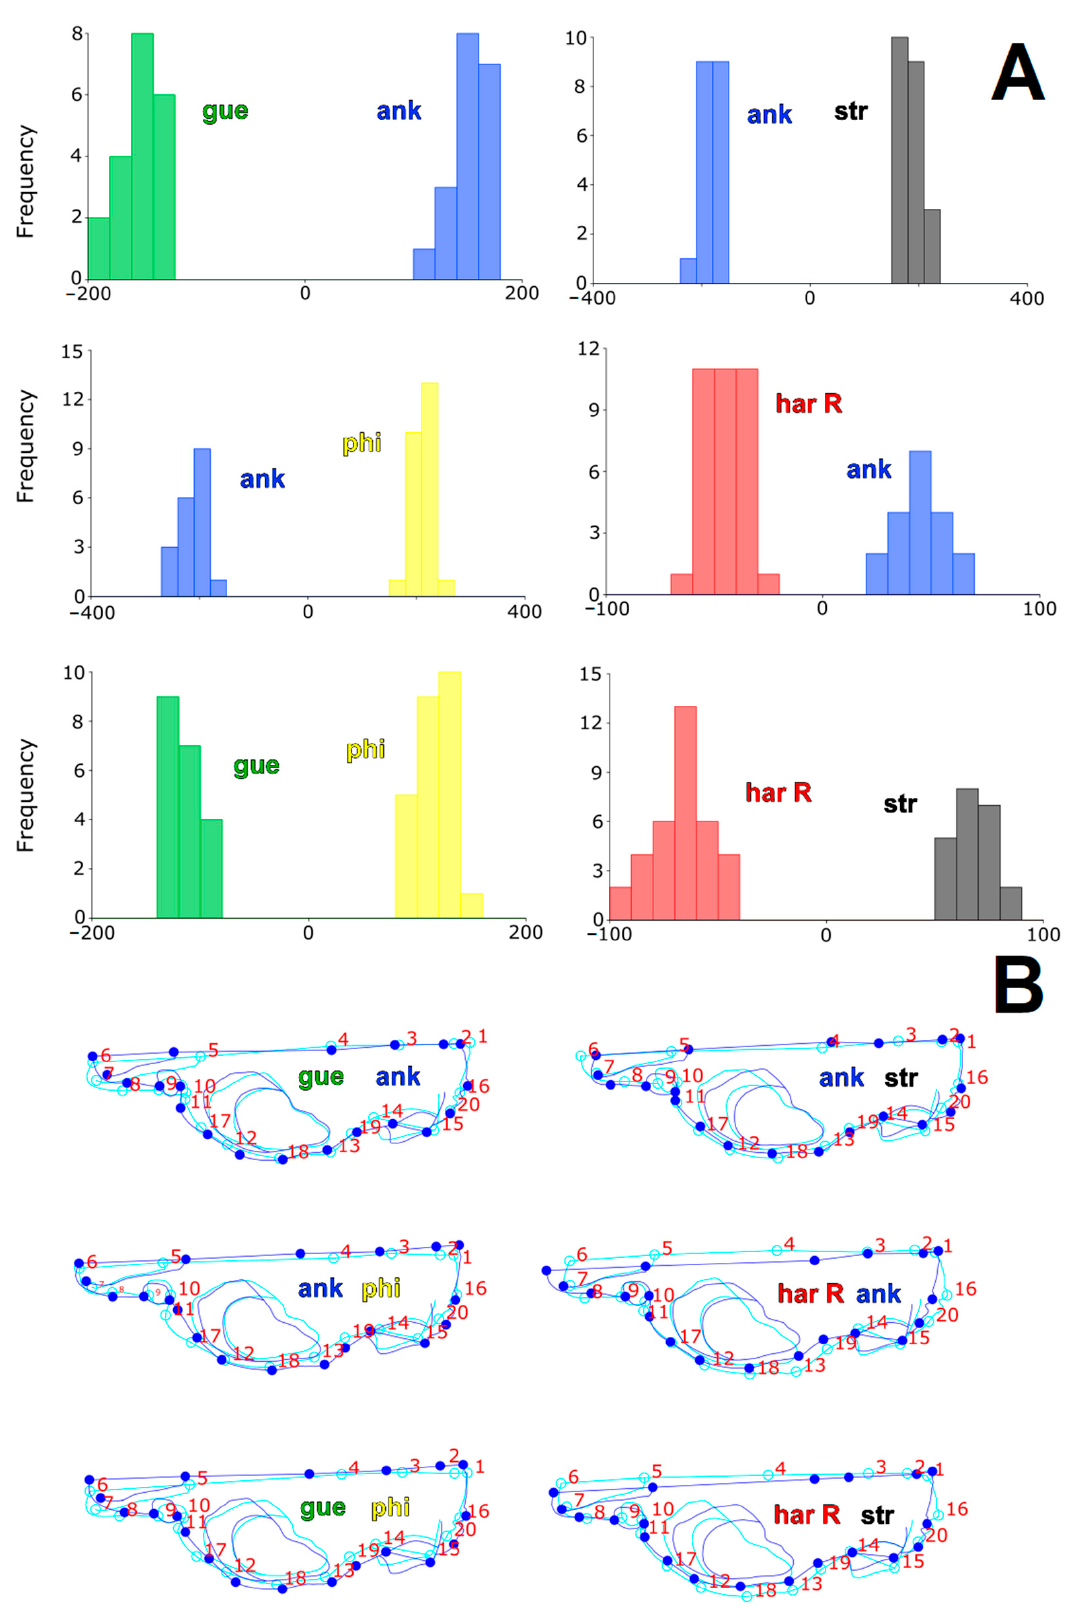
Figure 5. The DFA histogram ( A ) and shape ( B ) deformation results for cranial datasets from five vole forms in the “guentheri” group. Blue dots indicate landmarks after shape deformation; red numbers denote landmark numbers; the scale factor for deformation visualization: 4.0.